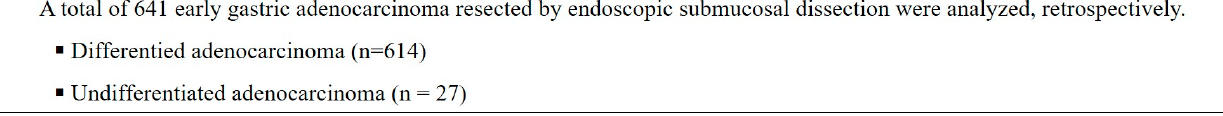
Figure 1. Schematic showing a flow chart of the study. ESD, endoscopic submucosal